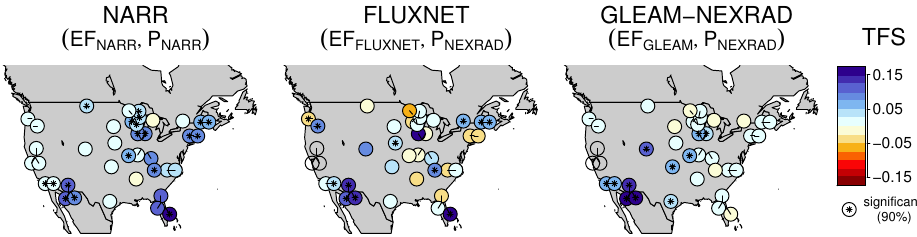
Figure 2. Triggering feedback strength (TFS ∗ ) in different data sets computed at FLUXNET sites. (left) Evaporative fraction (EF) and precipitation data from NARR, (center) EF from FLUXNET and precipitation from NEXRAD, and (right) EF from GLEAM and precipitation from NEXRAD. TFS ∗ values significantly different from 0 at the 90% level are indicated by a black asterisk. In case of overlap, points are shifted and the black lines inside the circles indicate the actual location of the station. Empty dots indicate sites with unreliable NEXRAD